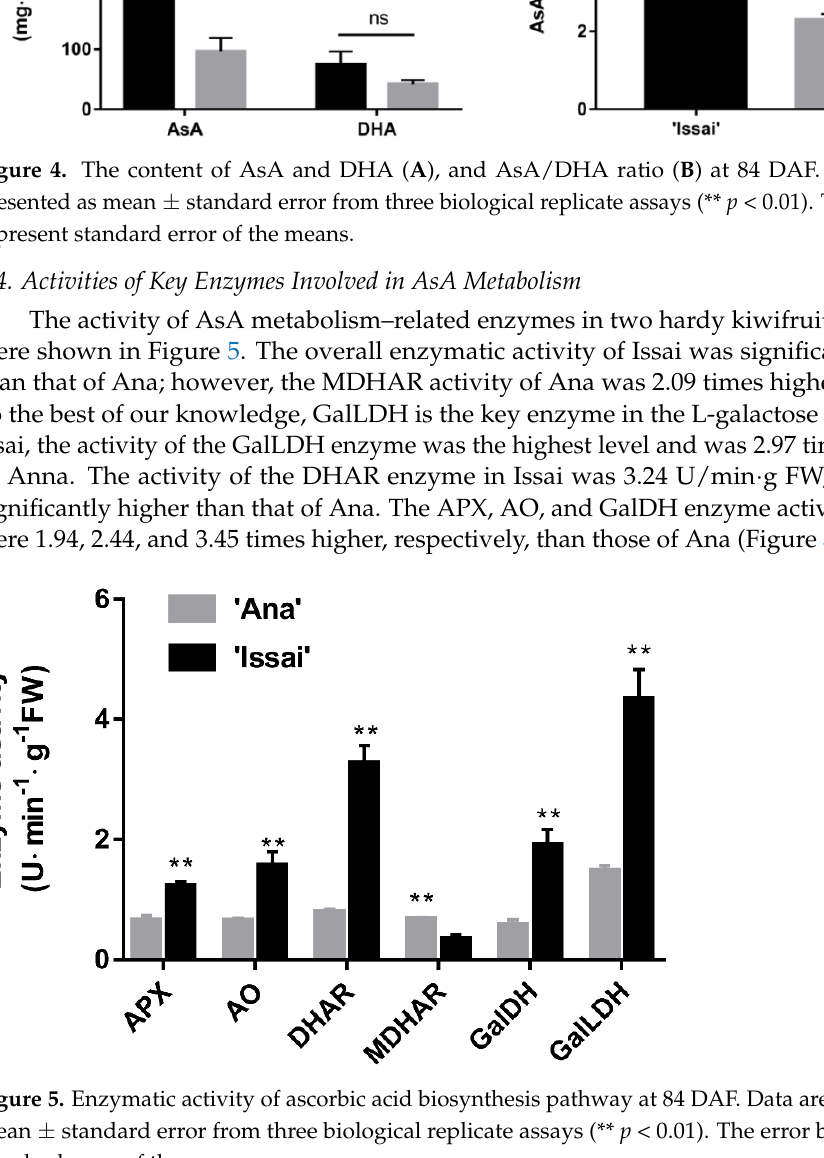
Figure 5. Enzymatic activity of ascorbic acid biosynthesis pathway at 84 DAF. Data are presented as mean ± standard error from three biological replicate assays (** p < 0.01). The error bars represent standard error of the means.